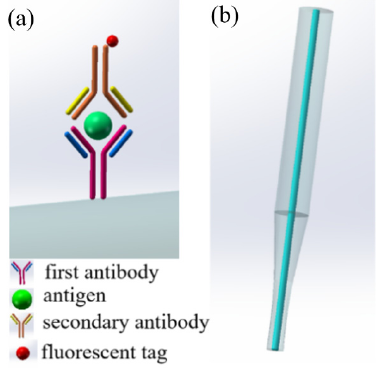
Figure 15. ( a ) The schematic diagram of fluorescent label detection and ( b ) a tapered fiber